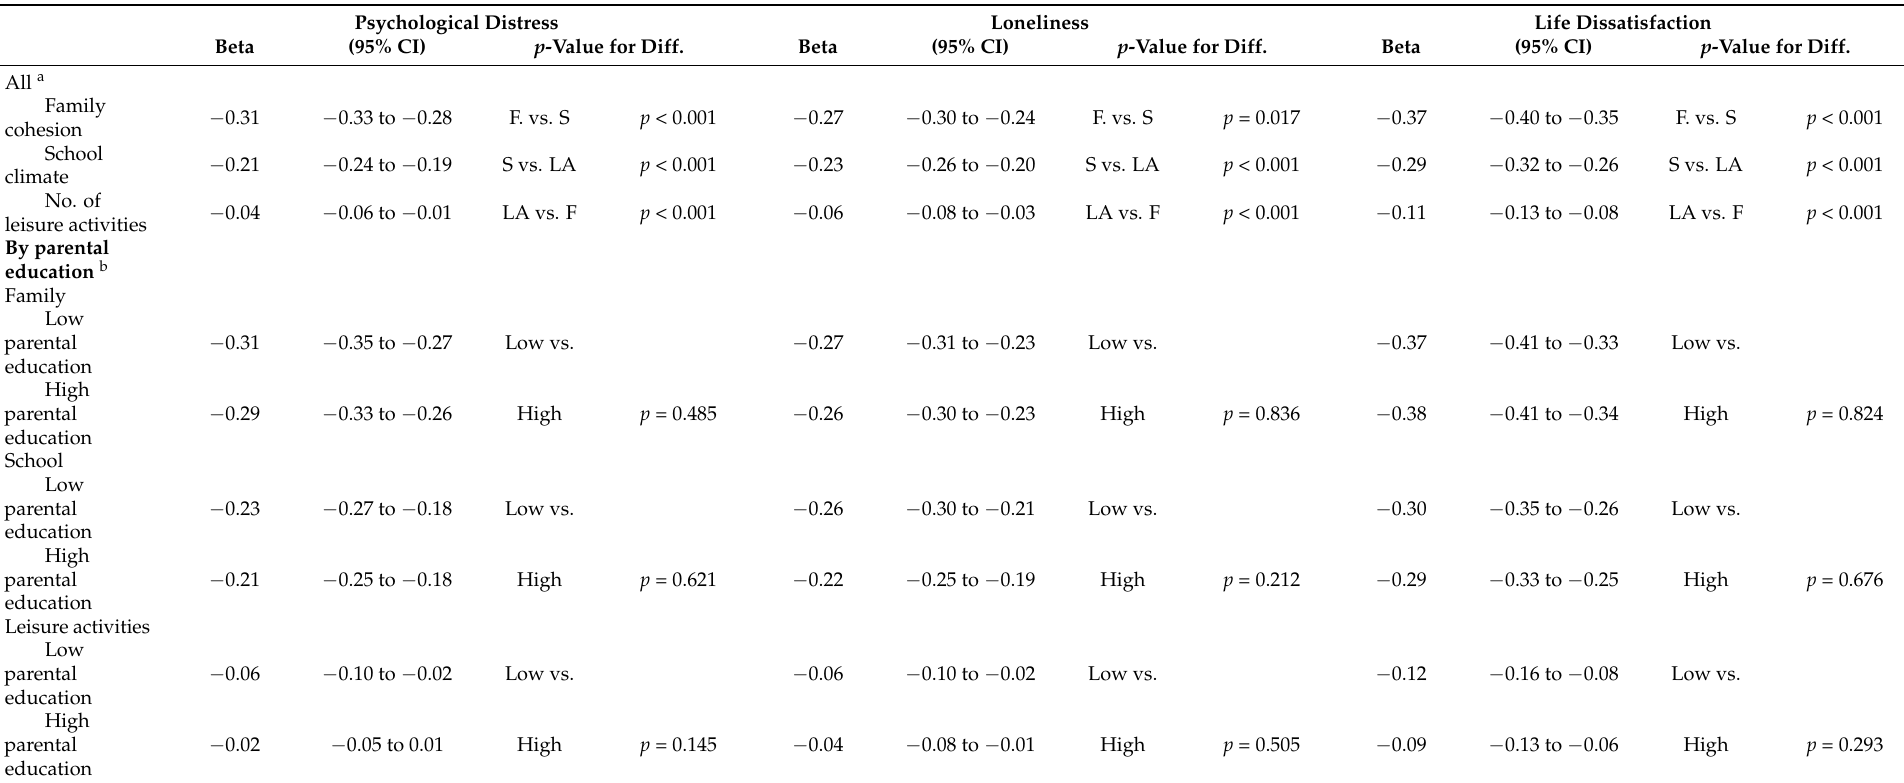
Table 2. Associations (standardized coefficients) between family cohesion, school environment, leisure activities and psychological distress, loneliness, and life dissatisfaction. Psychological Distress Loneliness Life Dissatisfaction Beta (95% CI) p -Value for Diff. Beta p -Value for Diff. p -Value for